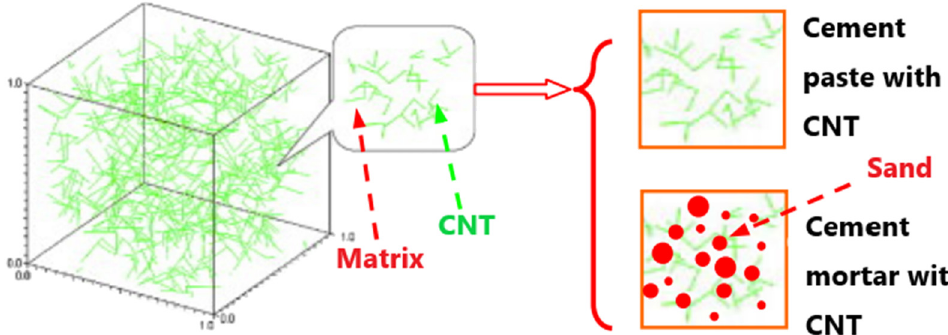
Figure 11: 3D contact network diagram of CNT in cement matrix [ 140 ]